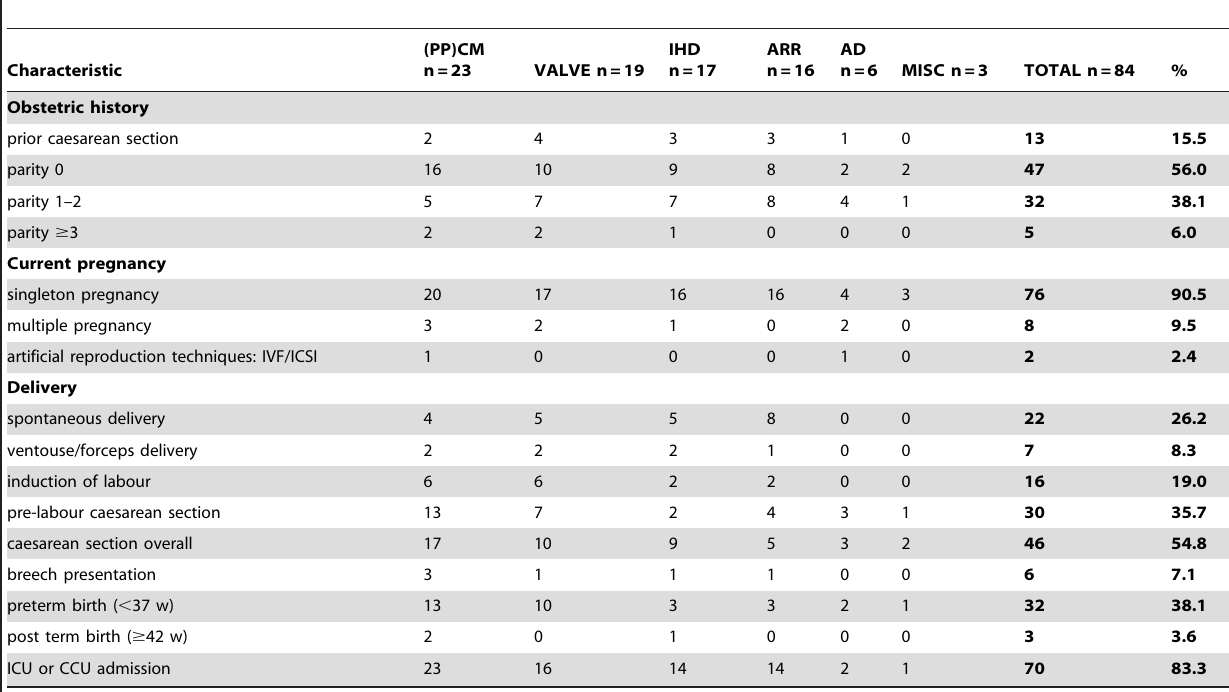
Table 3. Obstetric history and mode of delivery in women with severe maternal morbidity caused by cardiovascular disease.